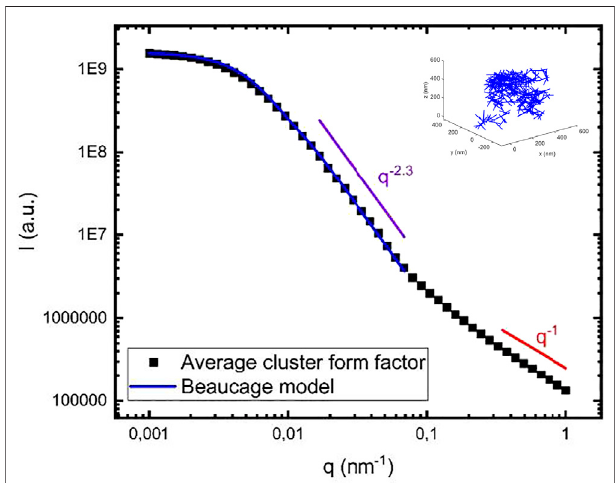
FIGURE 3 | Calculated cluster form factor obtained from averaging over 20 different clusters, each containing 400 fi brils (black squares) . As an example, one of the modeled clusters is shown in the inset. The blue line is a calculated scattering curve using the Beaucage model (see text) with G (cid:1) 1 . 610 − 9 , Rg (cid:1) 300nm and d (cid:1) 2 . 3. As a red line we show q − 1 dependence of the scattering intensity expected at high q and representing the single rod form factor, and as a purple line we show q − 2 . 3 dependence of the scattering intensity.